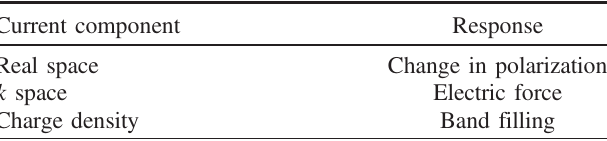
TABLE II. Summary of 2D phase-space responses. Current component